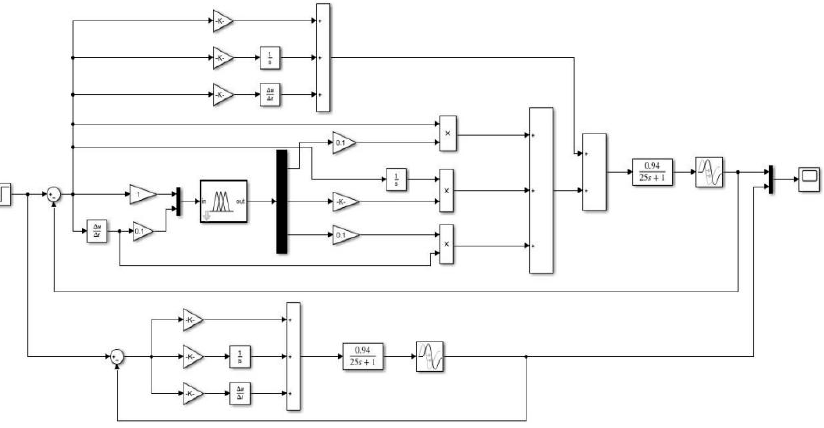
Figure 16. The simulation experimental platform.